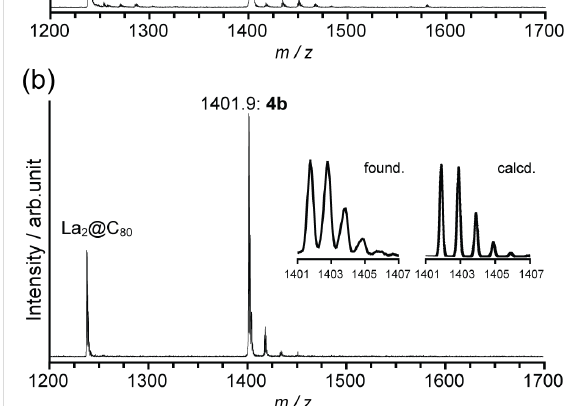
Figure 2: MALDI–TOF mass (negative mode) spectra of (a) 3b and (b) 4b , using 1,1,4,4-tetraphenyl-1,3-butadiene as matrix.